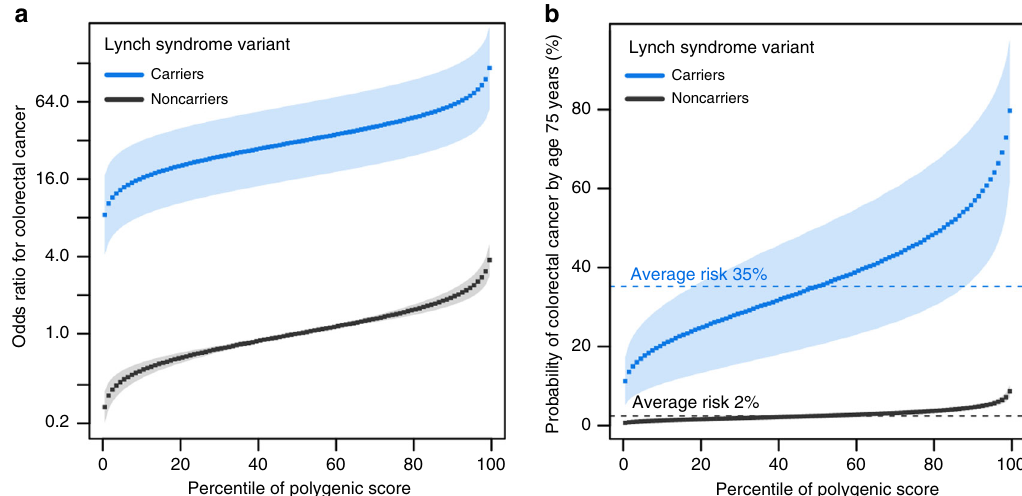
Fig. 3 Interplay of monogenic and polygenic risk for colorectal cancer. a Predicted odds ratio for colorectal cancer in each percentile (dots) of the polygenic score distribution for carriers (blue) and noncarriers (black) of Lynch syndrome variants in the cohort study derived from the UK Biobank ( n = 48,812). Noncarriers with median polygenic score served as the reference group. b Predicted probability of colorectal cancer by age 75 years in each percentile (dots) of the polygenic score distribution for carriers (blue) and noncarriers (black) of Lynch syndrome variants in the cohort study derived from the UK Biobank ( n = 48,812). The shaded area around the dots represents the 95% con fi dence interval. The horizontal dashed lines show the probability of disease for people with average polygenic risk per standard deviation increment in the colorectal cancer poly- genic score was 1.65 (95% CI 1.48 – 1.85). Joint modeling of